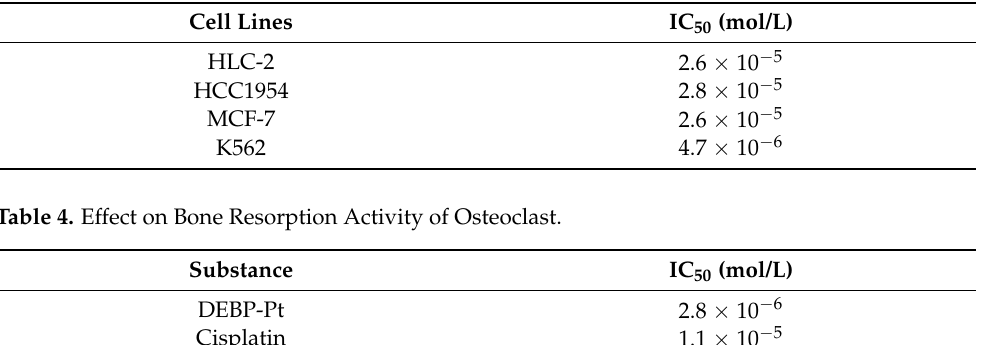
Table 3. Cytotoxicity of the DEBP-Pt, compound 29 against Various Human Tumor Cell Lines.